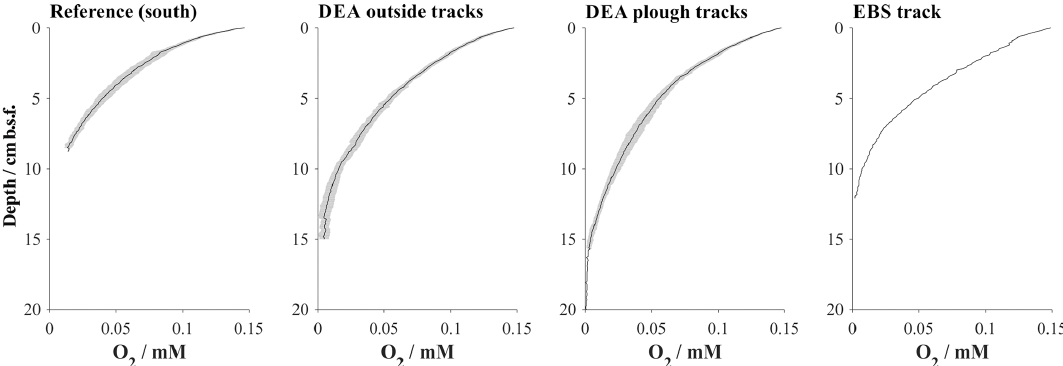
Figure 5. Averaged (black line) in situ oxygen profile representative of various disturbance settings including their standard deviations (shaded area). Because the depth steps between each measuring point of the oxygen profiles are very close, they are not resolved in the diagram. Details on individual sampling stations can be found in Table